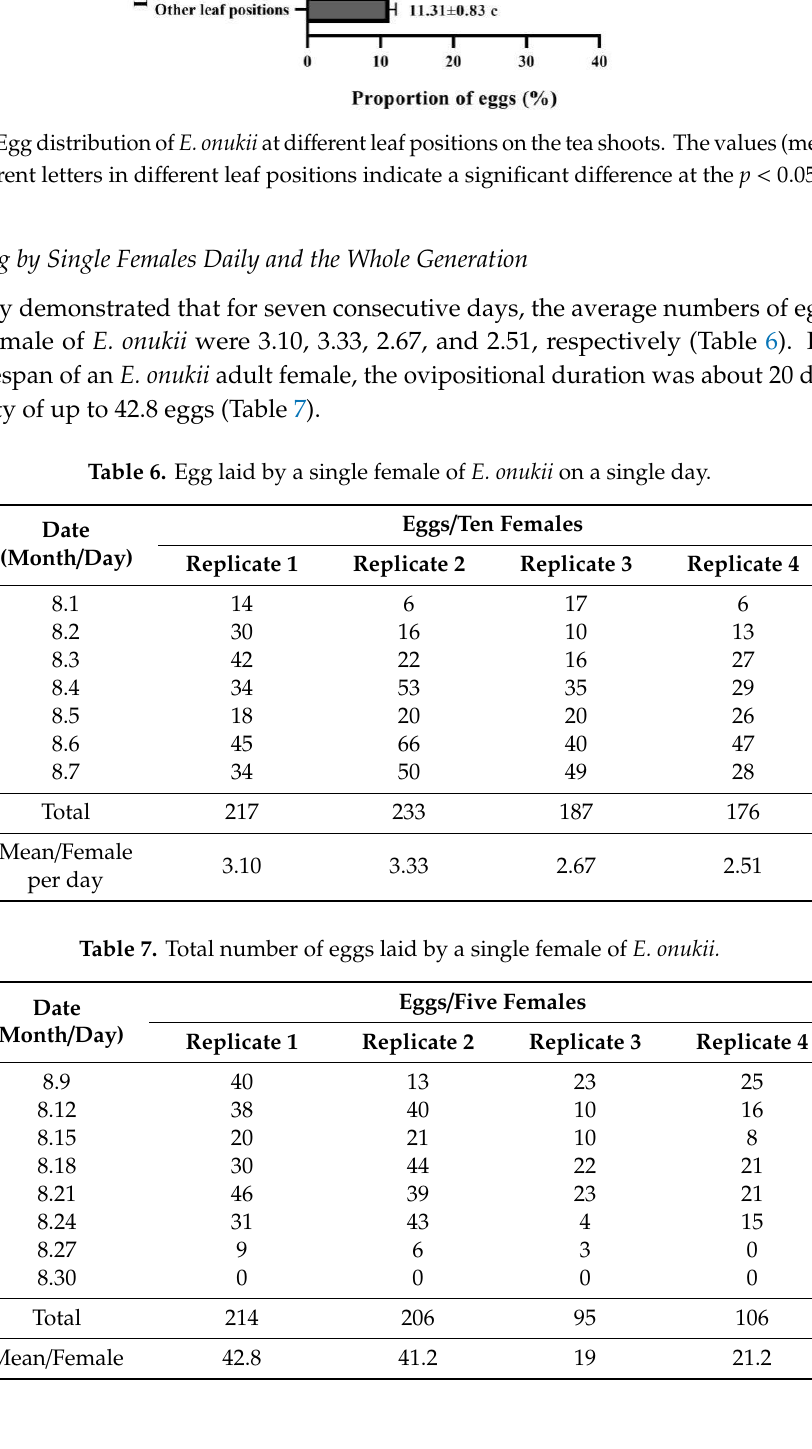
Figure 4. Egg distribution of E. onukii at different leaf positions on the tea shoots. The values (mean ± SE) with different letters in different leaf positions indicate a significant difference at the p < 0.05 level by LSD test.